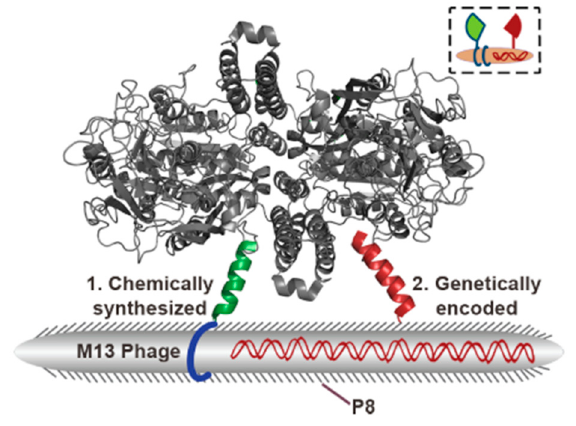
Figure 7. Scheme of a bifunctional M13 bacteriophage engineered to bind prostate-specific membrane antigen (PSMA). One peptide is fused into the pVIII major coat protein, while the second one is chemically bounded to phage particle [56]. Reprinted with permission from [56]. Copyright 2013 American Chemical Society.